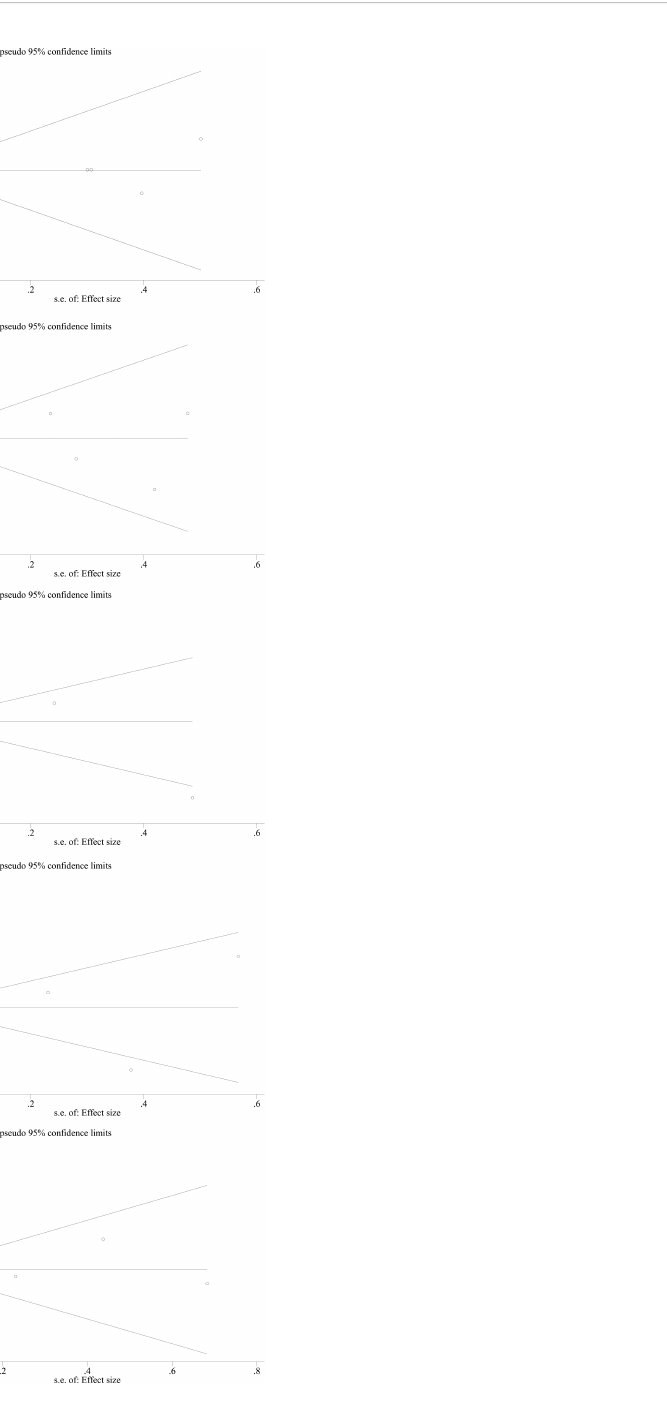
FIGURE 9 Begg ’ s funnel plot for relationship between ING3 expression and TNM stage (A) , lymph node metastasis (B) , tumor size (C) , tumor differentiation (D) and gender (E)